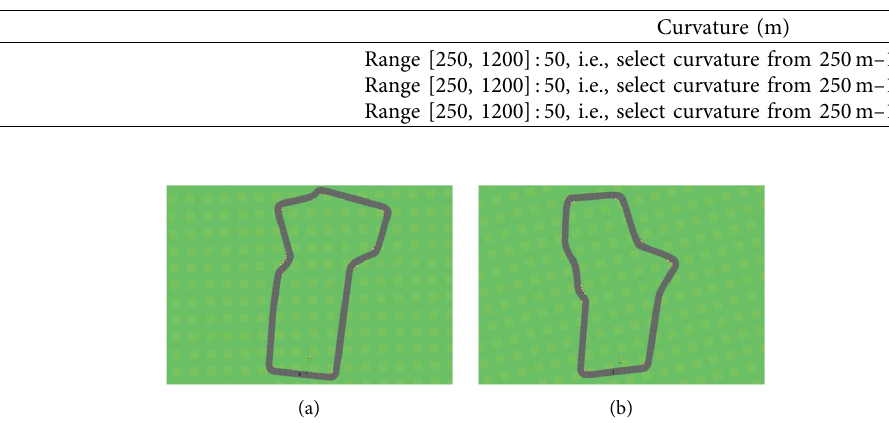
Table 2: Test matrix between speed and curvature.